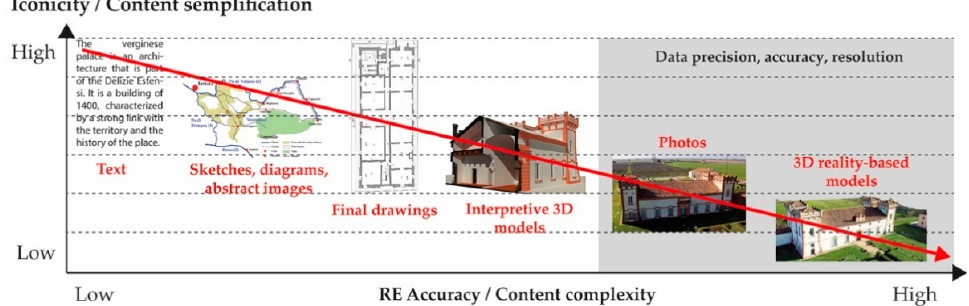
Figure 7. Graphic diagram showing the relationship between the iconicity of digital content and its descriptive